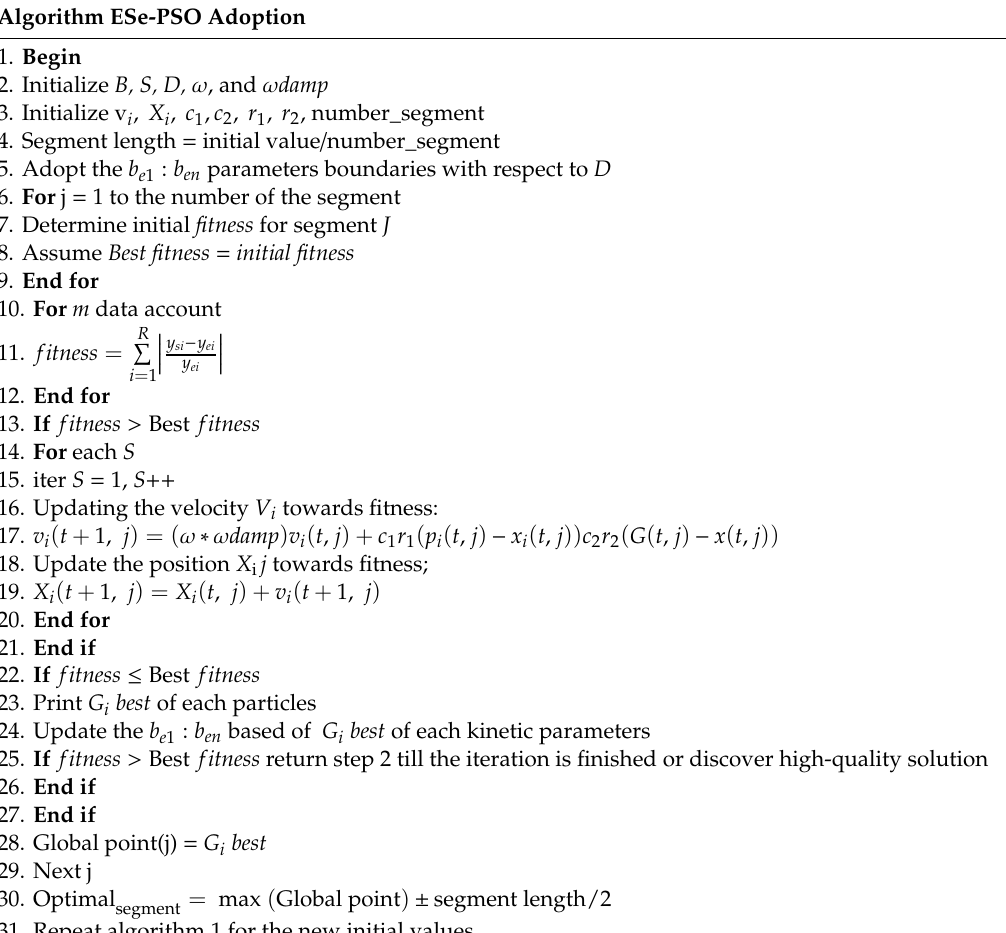
Table 1. Pseudo-code of Enhanced Segment Particle Swarm Optimization Algorithm